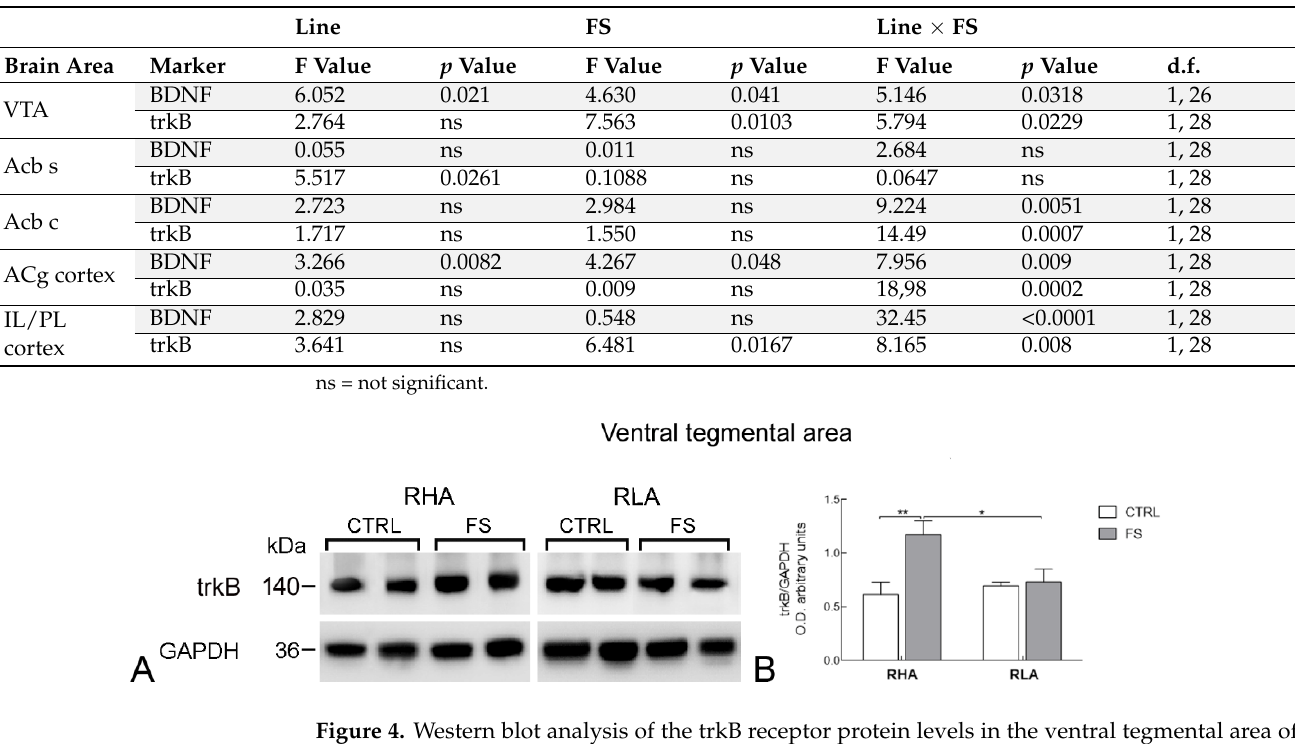
Table 2. F values and significance levels of two-way ANOVAs performed on WB data plotted in Figures 1–6.